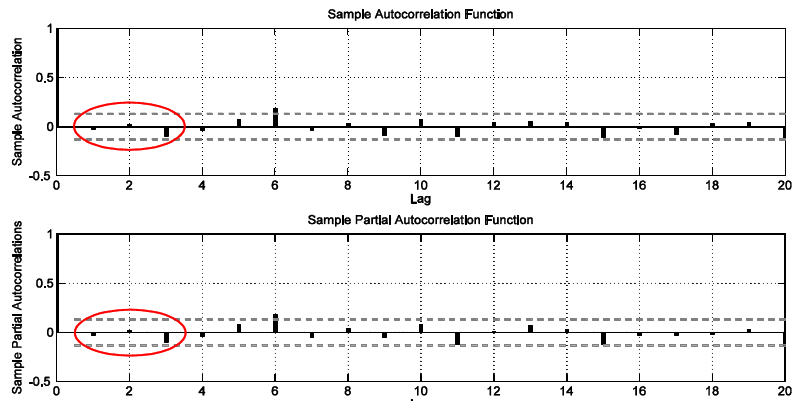
Figure 5. Residual Plot of ACF and PACF for Petaling district ARIMA (2,1,0).